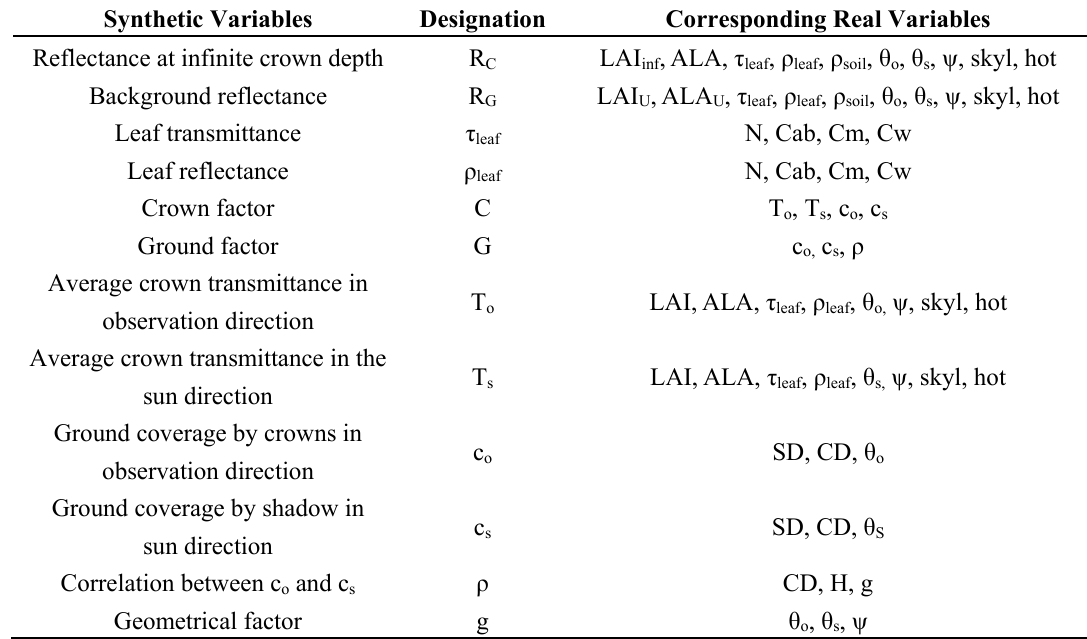
Table 3. Summary of main invertible forest reflectance model (INFORM) parameters. Variable meaning is given in the main